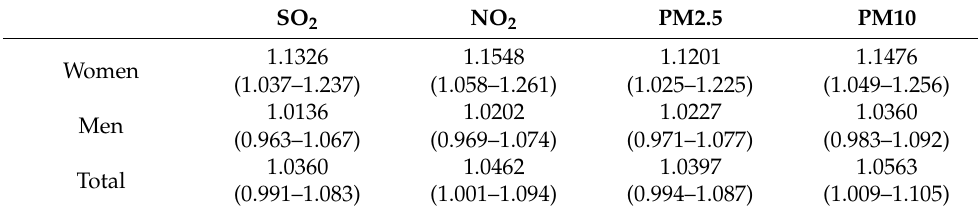
Table 1. Risk ratio for the population below the median age (<75) (with 0.95 confidence interval). SO 2 NO 2 PM2.5 PM10 Women